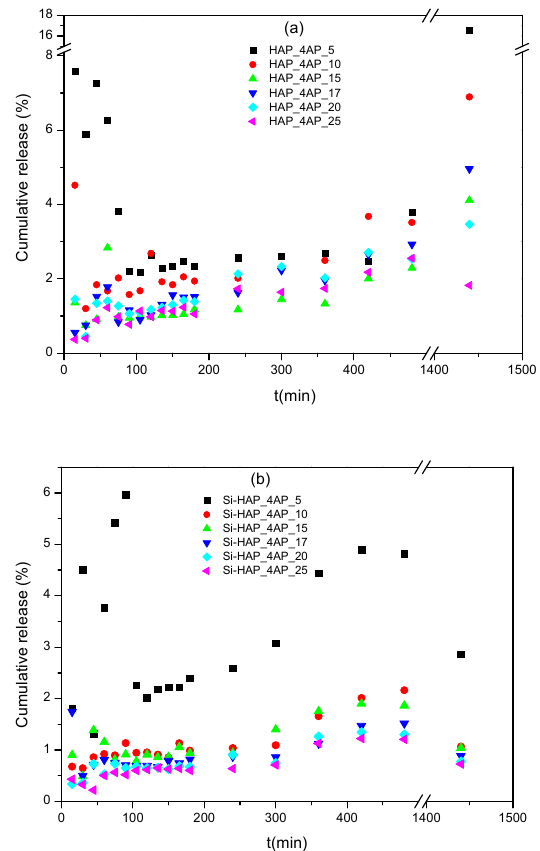
Figure 7. Cumulative release profile of 4AP from ( a ) HAP and ( b ) Si–HAP carriers.